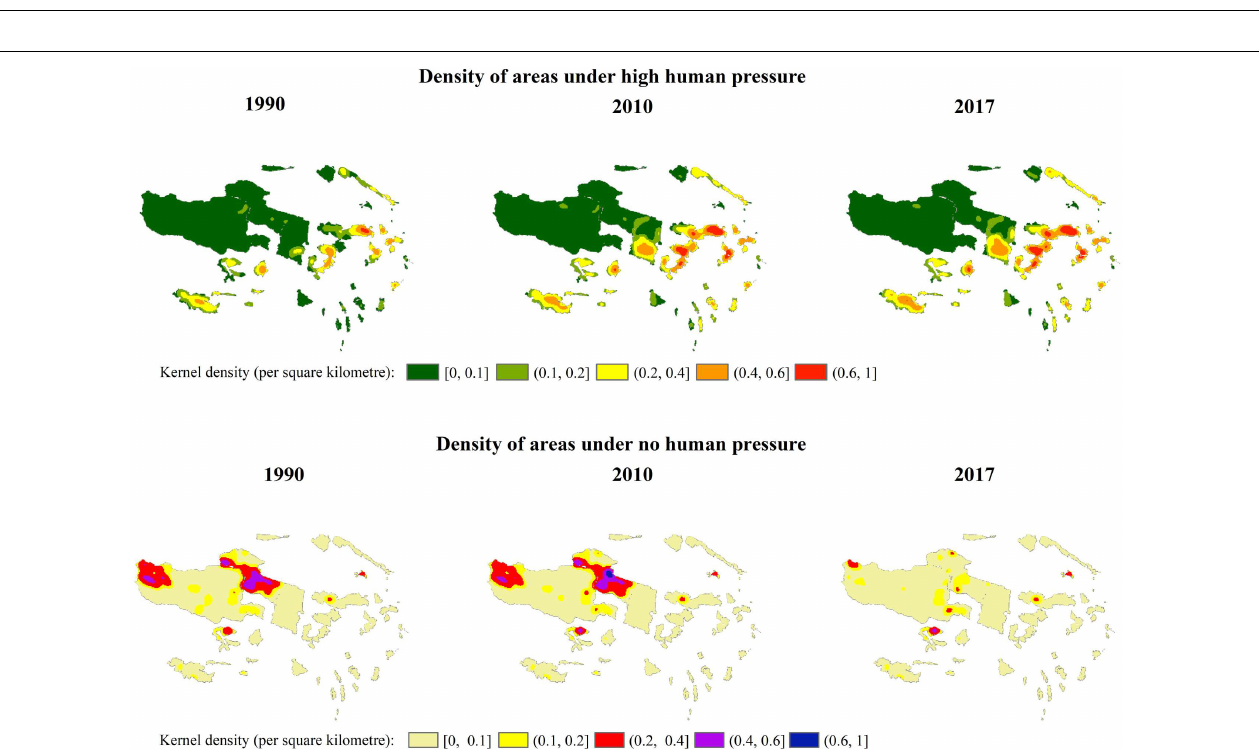
FIGURE 6 | Aggregation areas of KBAs with human pressure above 10 and under no human pressure in NNRs during 1990–2017.